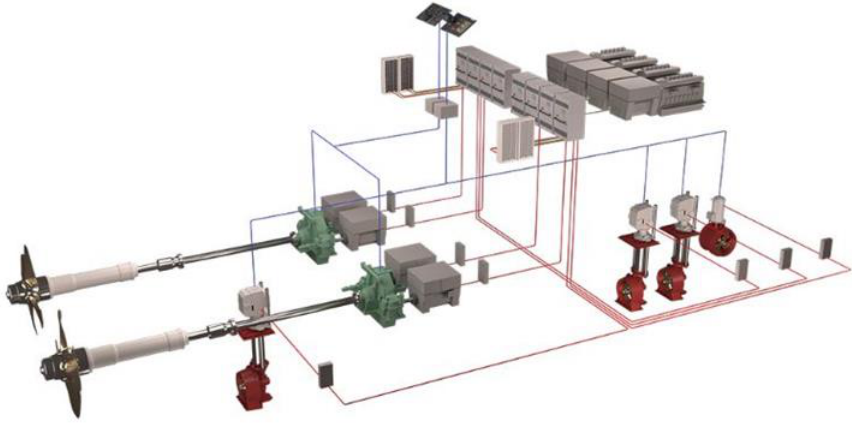
Figure 3. Typical setup of a diesel/gas electric battery hybrid propulsion system [46].